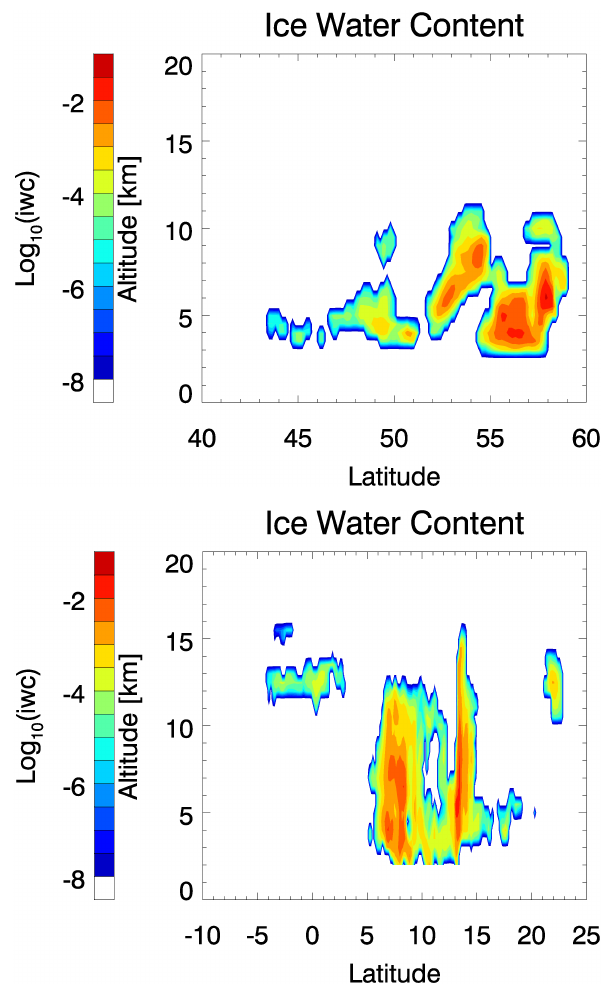
Fig. 7. Latitude-altitude cross section of ice water content in gm − 3 and log 10 scale from ECMWF data. These data were input to the radiative transfer calculation with FM2D/SHDOM for Scenario 1 and 2 (top/bottom: mid and tropical